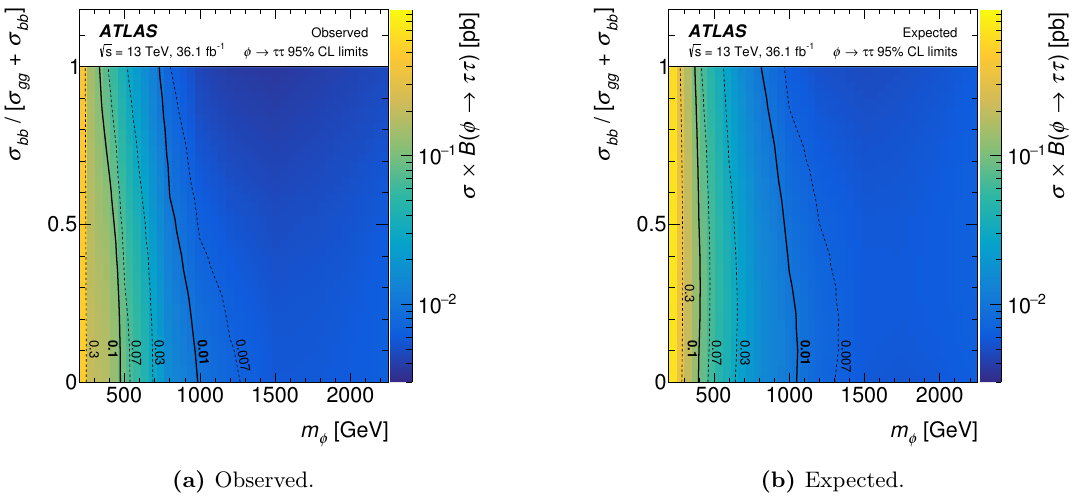
Figure 8. The (a) observed and (b) expected 95% CL upper limit on the production cross section times branching fraction for (cid:30) (cid:28)(cid:28) as a function of the fractional contribution from b -associated ! production and the scalar boson mass. The solid and dashed lines represent contours of (cid:12)xed (cid:27)